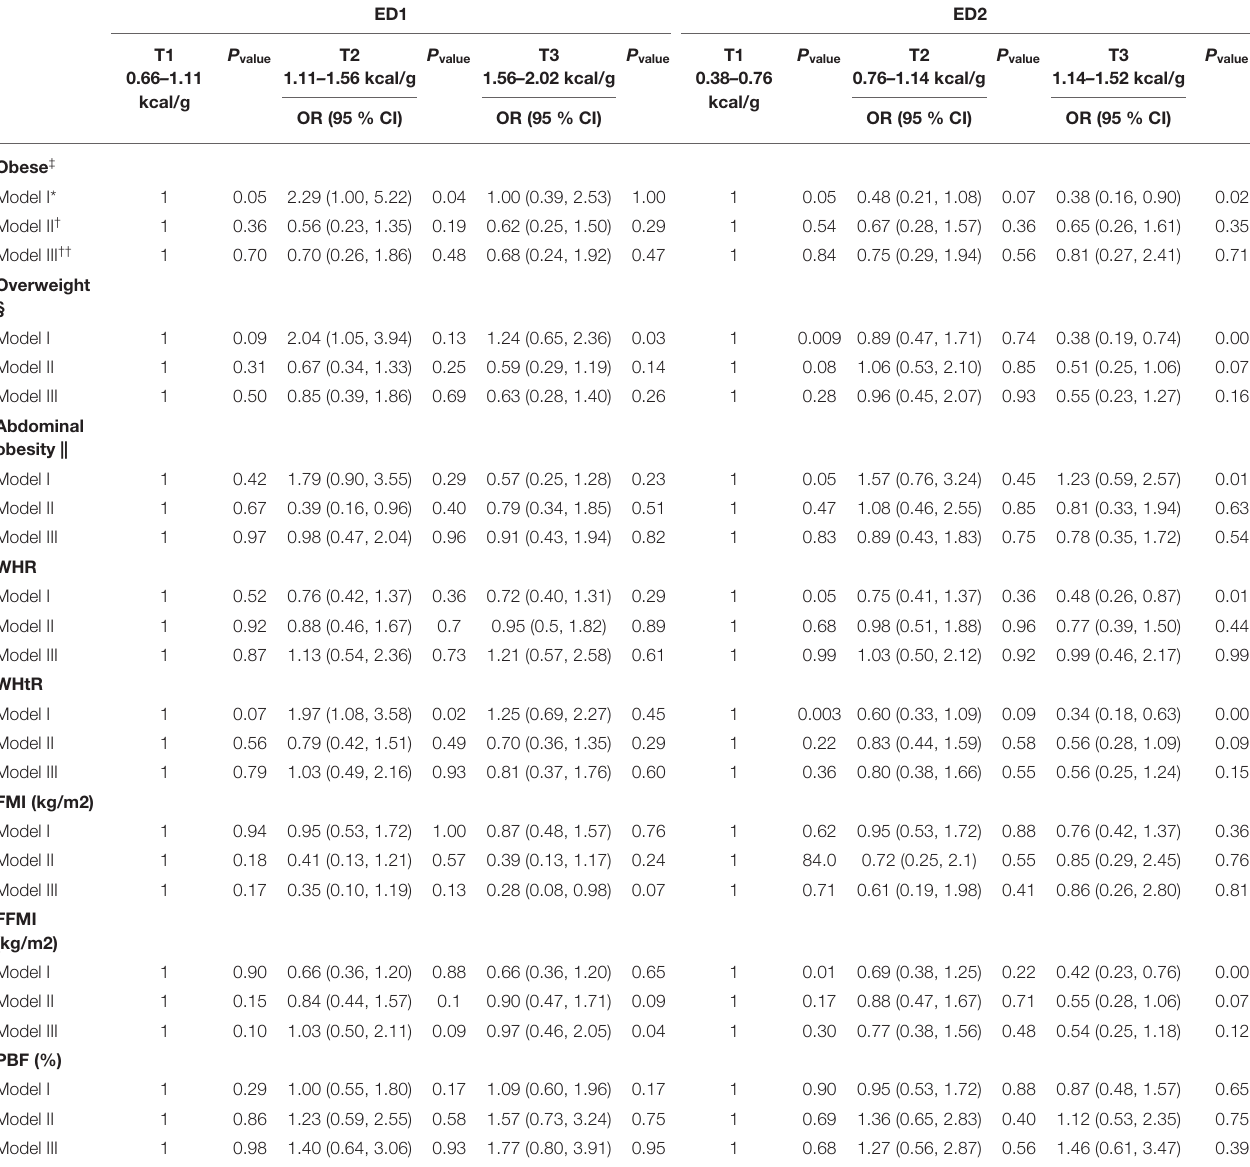
TABLE 4 | Multivariable-adjusted odds ratios (OR) and 95% CIs of WC, FMI, and body composition components according to tertiles of DED in a sample of Iranian